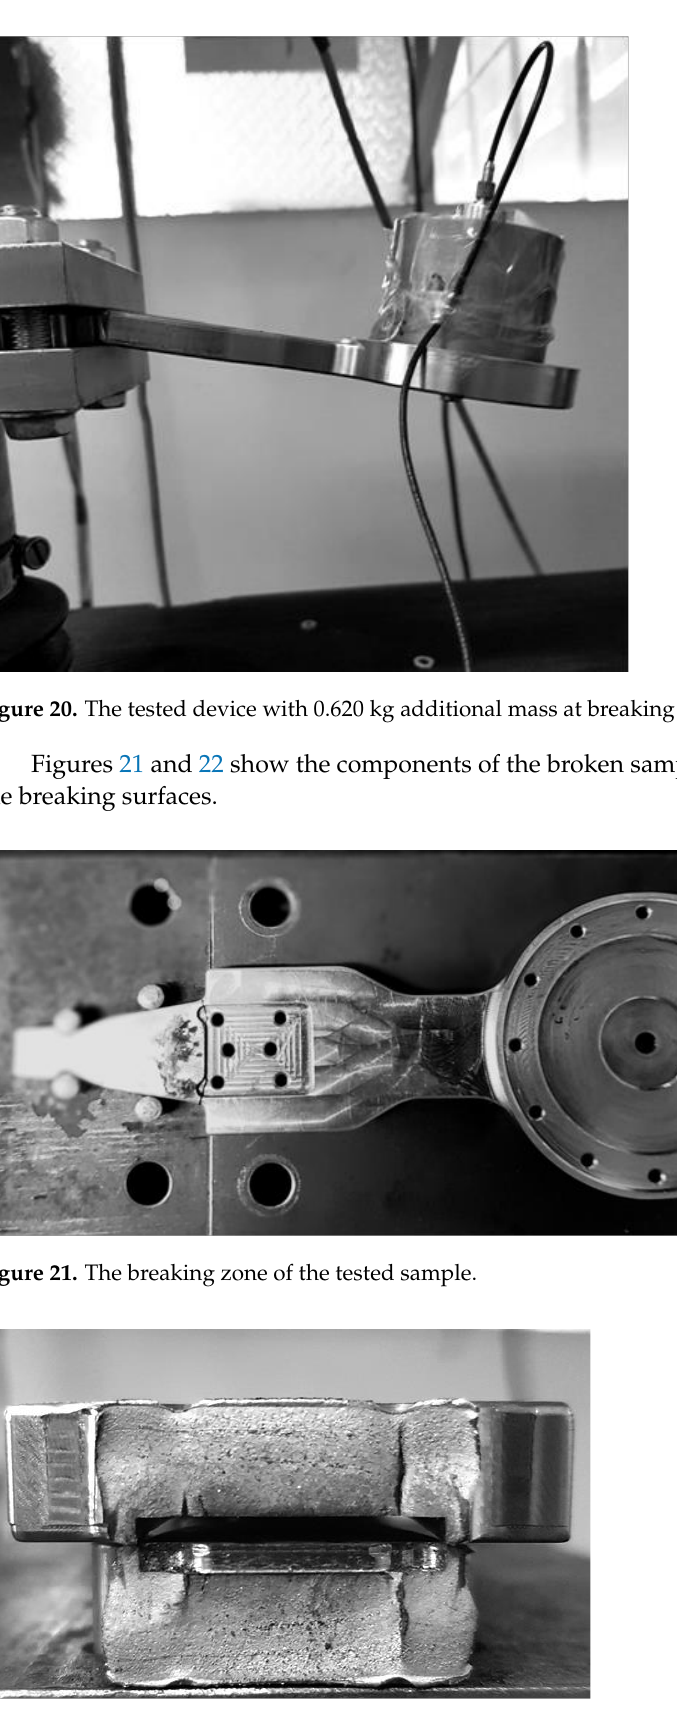
Figure 19. Evolution of the macroscopic damage variable with number of cumulative cycles. Figure 20 captures the breaking moment of the tested device.